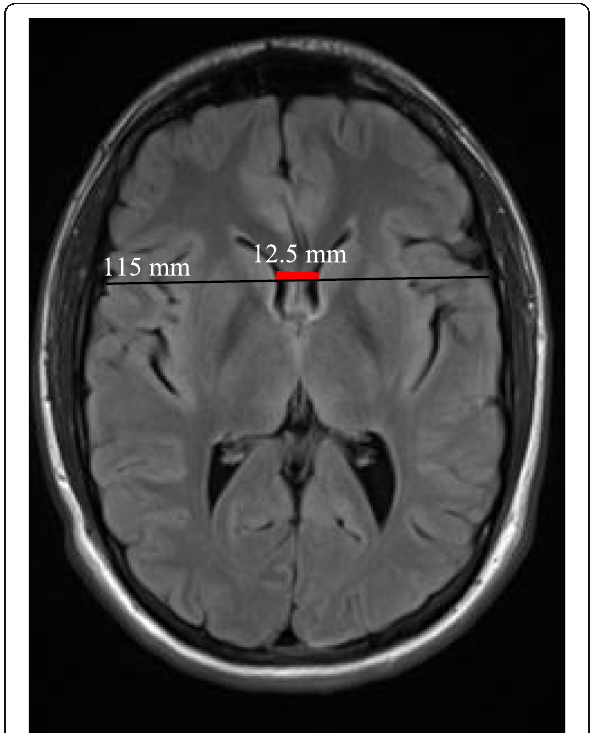
Fig. 2 Axial FLAIR image at the level of caudate nuclei showing the bi-caudate ratio (the inter caudate distance (red line, 12.5 mm) divided by the while brain width at the same level (black line, 115 mm) (BCR =